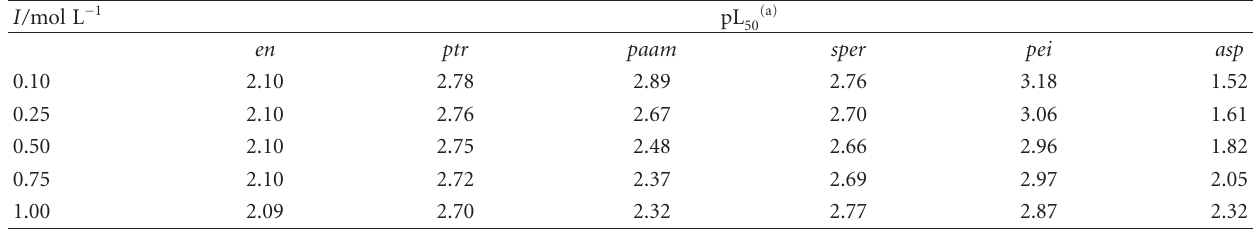
(a) ± 0 . 01-0 . 02 standard deviation.